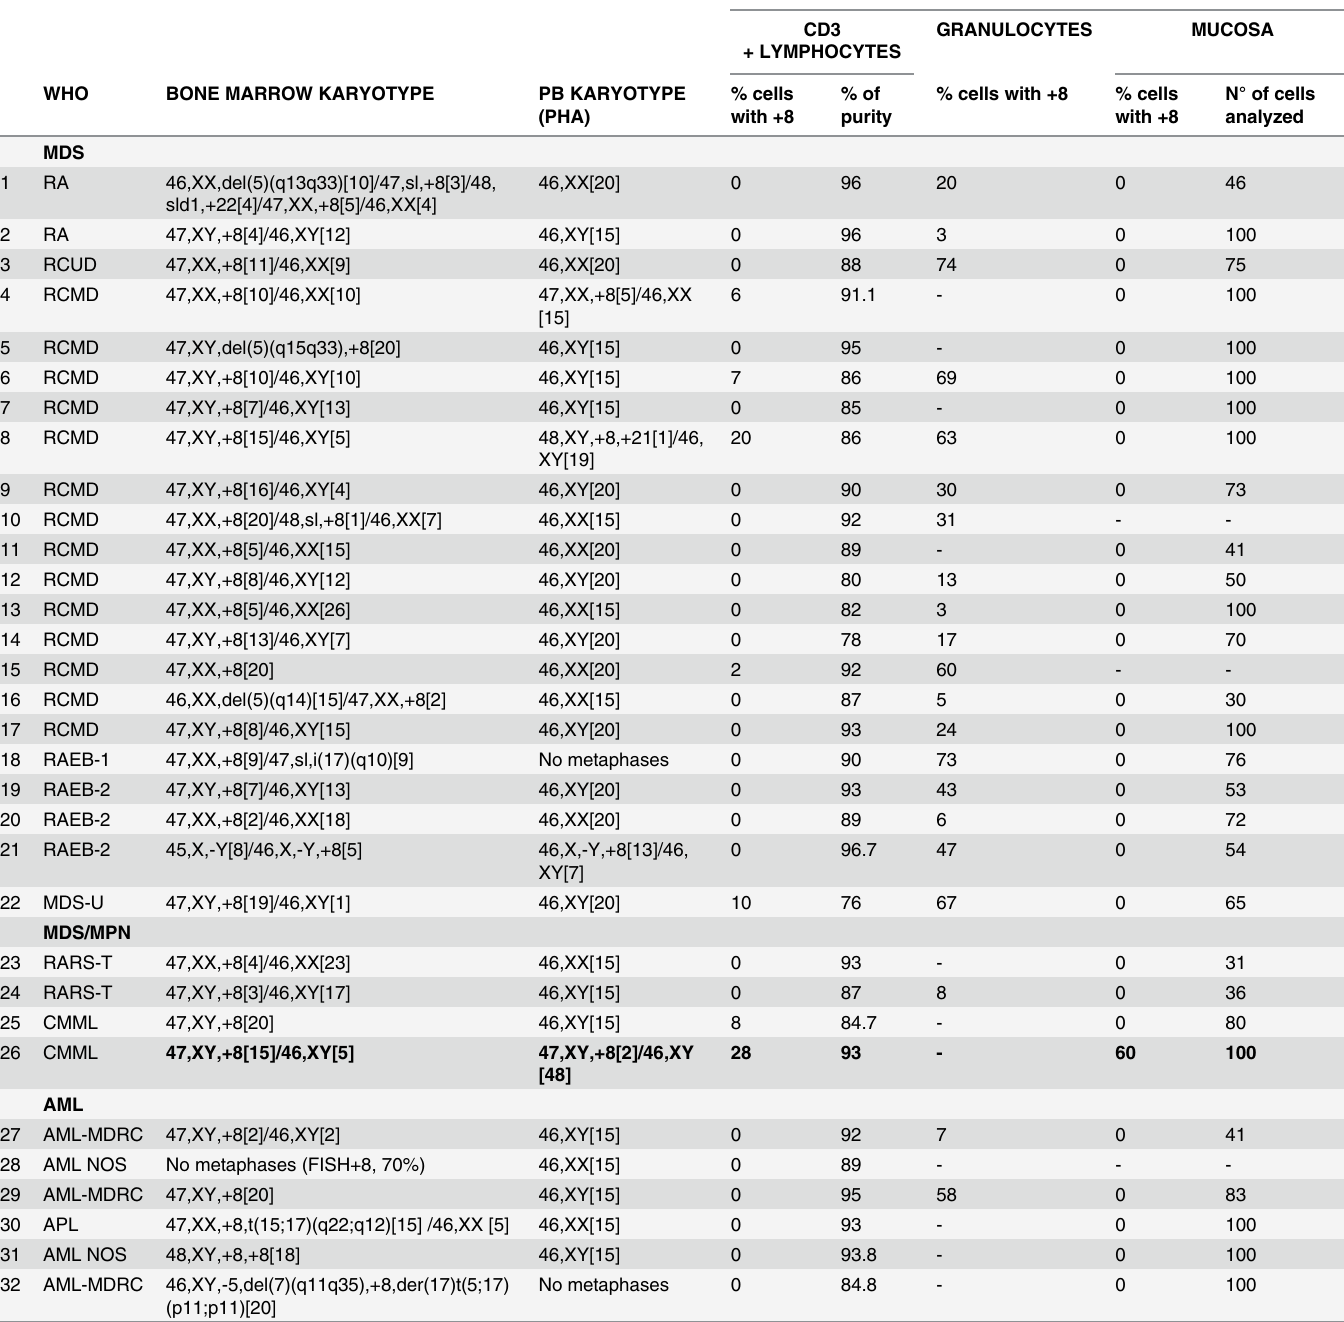
Table 1. Patient